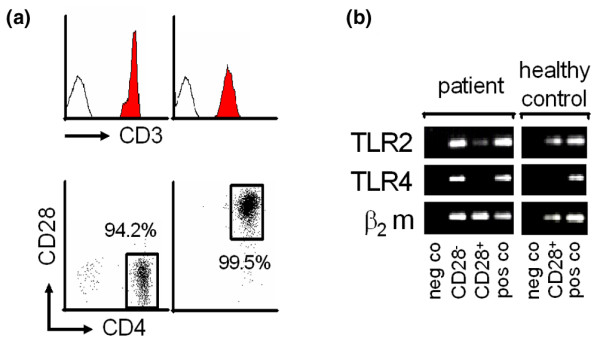
Messenger RNA expression of TLR2 and TLR4 in CD3+CD4+CD28null and CD3+CD4+CD28+ T cells. (a) Fluorescence-activated cell sorting analysis shows the purity of CD3+CD4+CD28null and CD3+CD4+CD28+ T cells. (b) mRNA expression of TLR2, TLR4 and β2-microglobulin (β2m, housekeeping gene) in CD3+CD4+CD28null T cells (CD28-) and in CD3+CD4+CD28+ T cells (CD28+). Peripheral blood mononuclear cells were used as positive control (pos co), and a negative control (neg co) was performed in the absence of cDNA. A representative example out of three independent experiments is given.